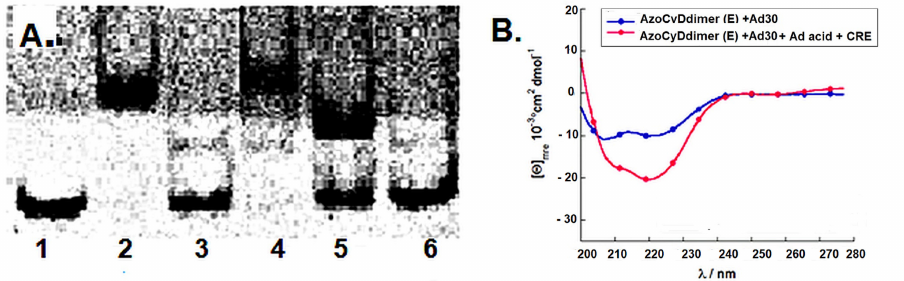
Figure 7. ( A ) EMSA analysis of DNA binding of Ad30–azoCyDdimer (E)–Ad30 in the absence and presence of 1-adamantane acetic acid. Lanes 1–5: 50 nM CRE ( (cid:48) 5-cggATGA cg TCATtttttttc-3 (cid:48) ); lane 2: 300 nM SS60; lane 3: 200 nM Ad30; lane 4: 200 nM Ad30 and 100 equiv azoCyDdimer (E); lane 5: 200